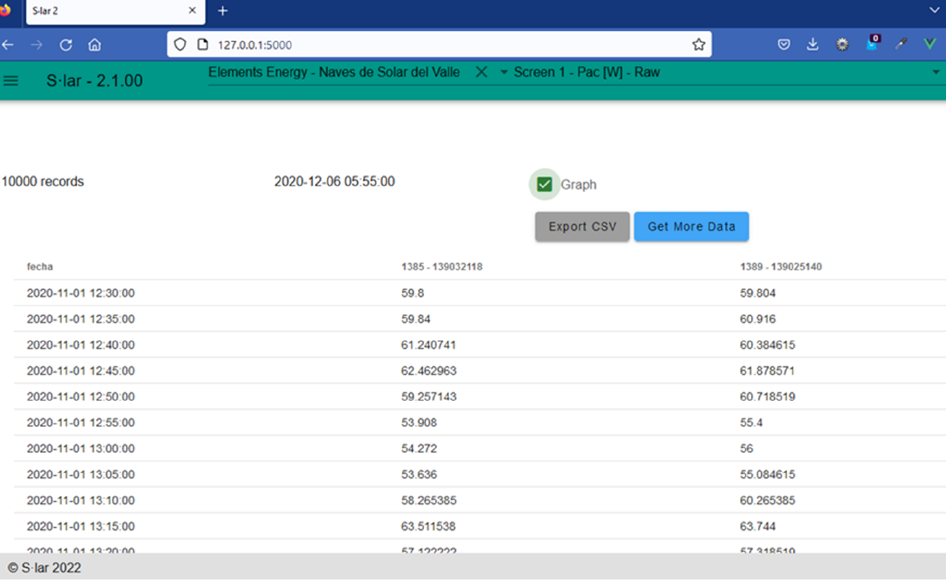
Figure 10. Image of the S·lar 2 application screen, showing in tabular form the values of one of the parameters ( P ac ) of the two selected inverters.